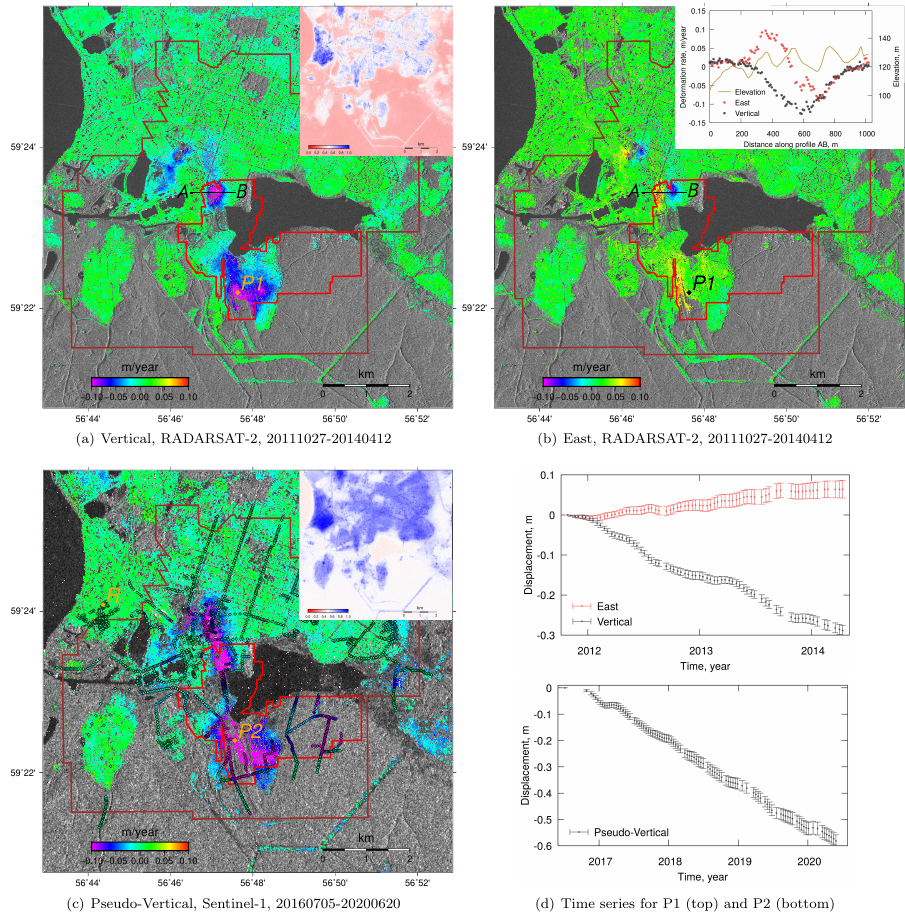
Figure 3. Vertical ( a ) and east ( b ) components of linear deformation rate during 27 October 2011–12 April 2014 computed from RADARSAT-2 ascending and descending SAR data. Pseudo-vertical linear deformation rate during 5 July 2016–20 June 2020 computed from Sentinel-1 descending SAR data and geodetic leveling vertical deformation rate during 2018–2019 (shown as colour-coded circles, c ). Deformation time series for regions P1 and P2 ( d ). SAR intensity images are used as background. The outlines of mining operations of carnallite (seam B) and sylvinite (seam Kr II) are shown as red and brown polygons, respectively. Inserts in ( a , c ) show mean interferometric coherence for entire set after filtering. Insert in ( b ) shows vertical and east deformation rate and elevation along profile